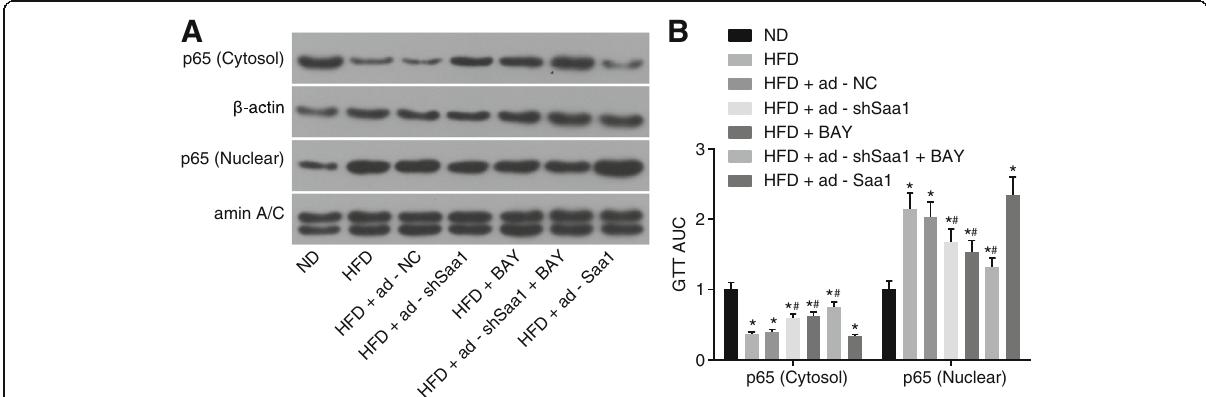
Fig. 5 NF- κ B pathway is activated by Saa1 in HFD mouse models. a , the grey value of cytoplasmic p65 and nucleus p65 protein bands in liver tissues of HFD mice after fed for 16 weeks, determined by western blot analysis; b , the protein expression of cytoplasmic p65 and nucleus p65 in liver tissues of HFD mice; *, p <0.05 vs. the ND group; #, p <0.05 vs. the HFD group; data were expressed by means ± standard deviation; multiple groups were compared by one-way analysis of variance; n=15; NF- κ B, nuclear factor- κ B; SAA1, serum amyloid A protein 1; ND, normal diet; HFD, high-fat diet; NC, negative